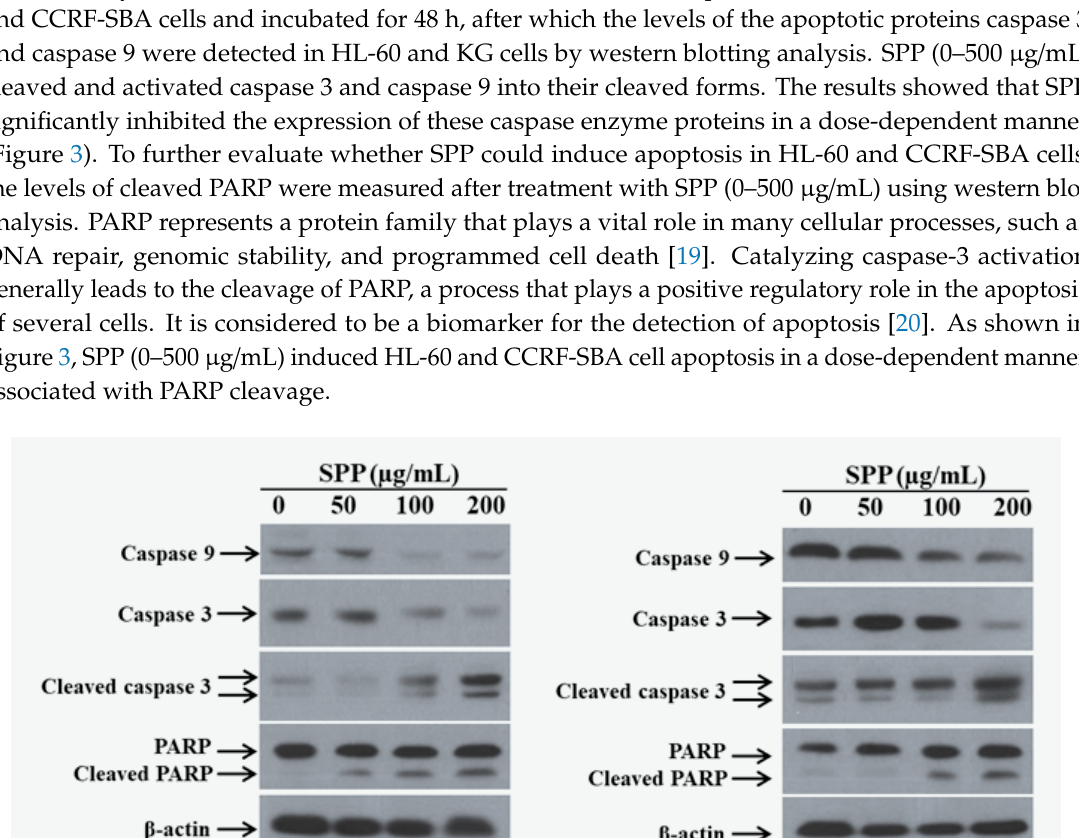
Figure 4. Effects of SPP on regulation of Bcl-2 family proteins of HL-60 ( A ) and CCRF-SBA cells ( B ). Data are representative of three independent experiments. 3. Discussion In recent years, studies have been performed to examine various plant-derived natural extracts, which are safe to use as antioxidant, anticancer, and other disease treatments, with fewer side effects than pharmaceutical products. In our experiment, ethanolic extracts of both the leaves and stem bark of P. pterocarpum were found to be active in lipid peroxidation and cytotoxicity. Previously, P.